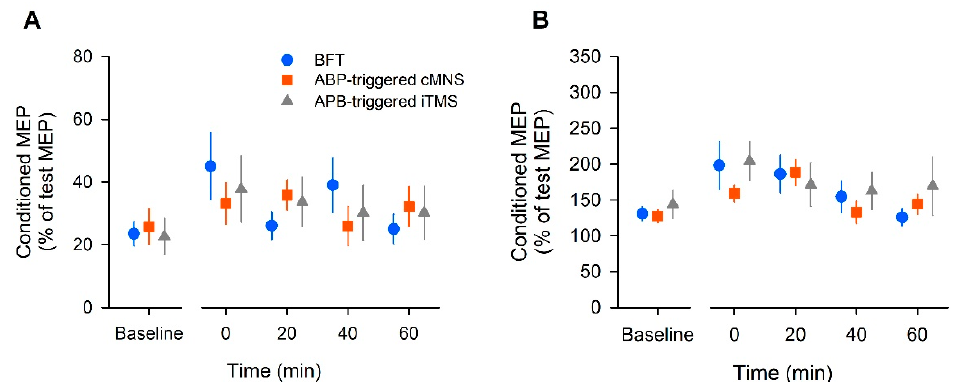
Figure 3. The population data of short-interval intracortical inhibition (SICI) ( A ) and intracortical facilitation (ICF) ( B ) in all participants. The conditioned MEP amplitude was expressed as a percentage of the unconditioned MEP amplitude. Each plot and error bar represents the mean and standard error of the mean, respectively.